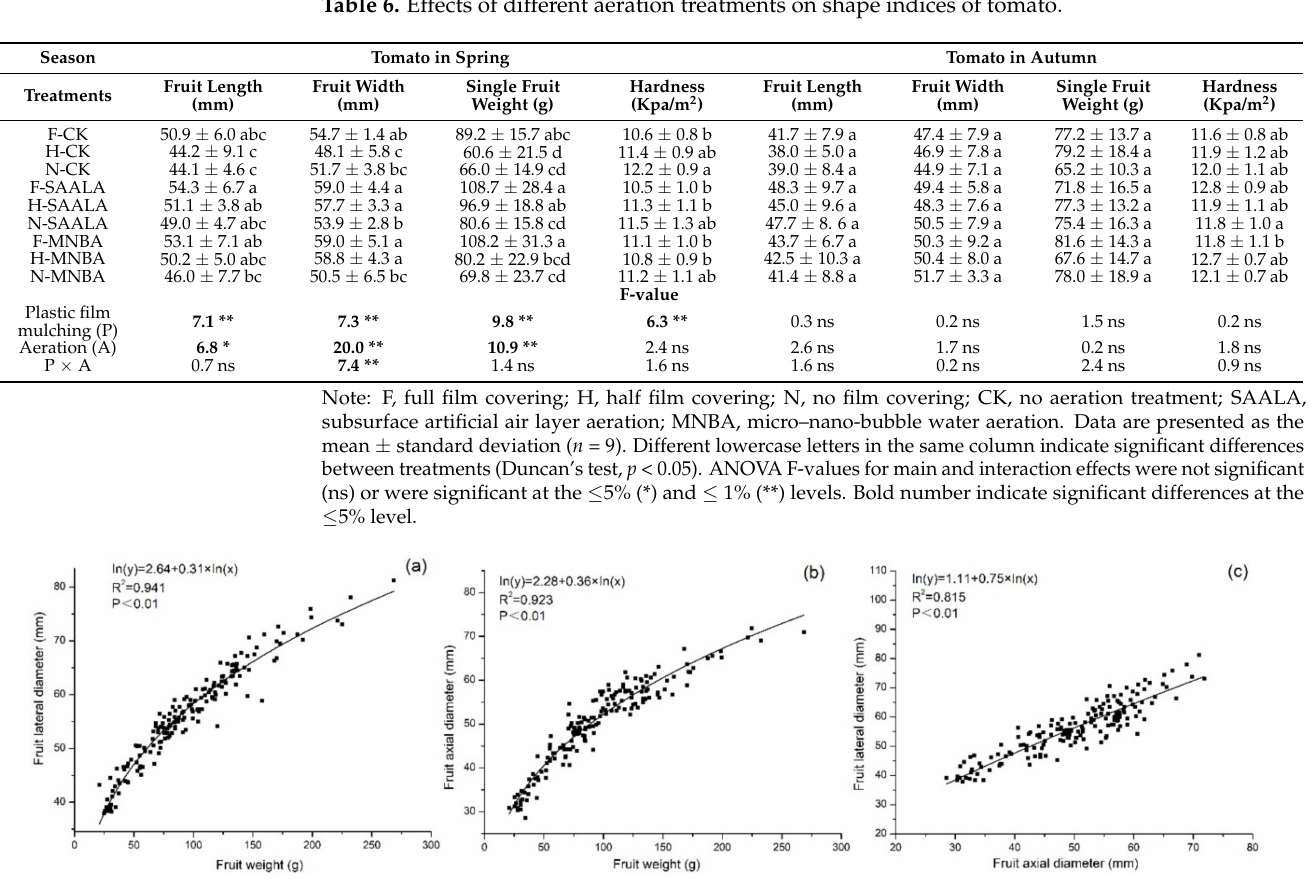
Figure 2. Relationships between ( a ) fruit weight and width, ( b ) fruit weight and length ( c ) fruit width and